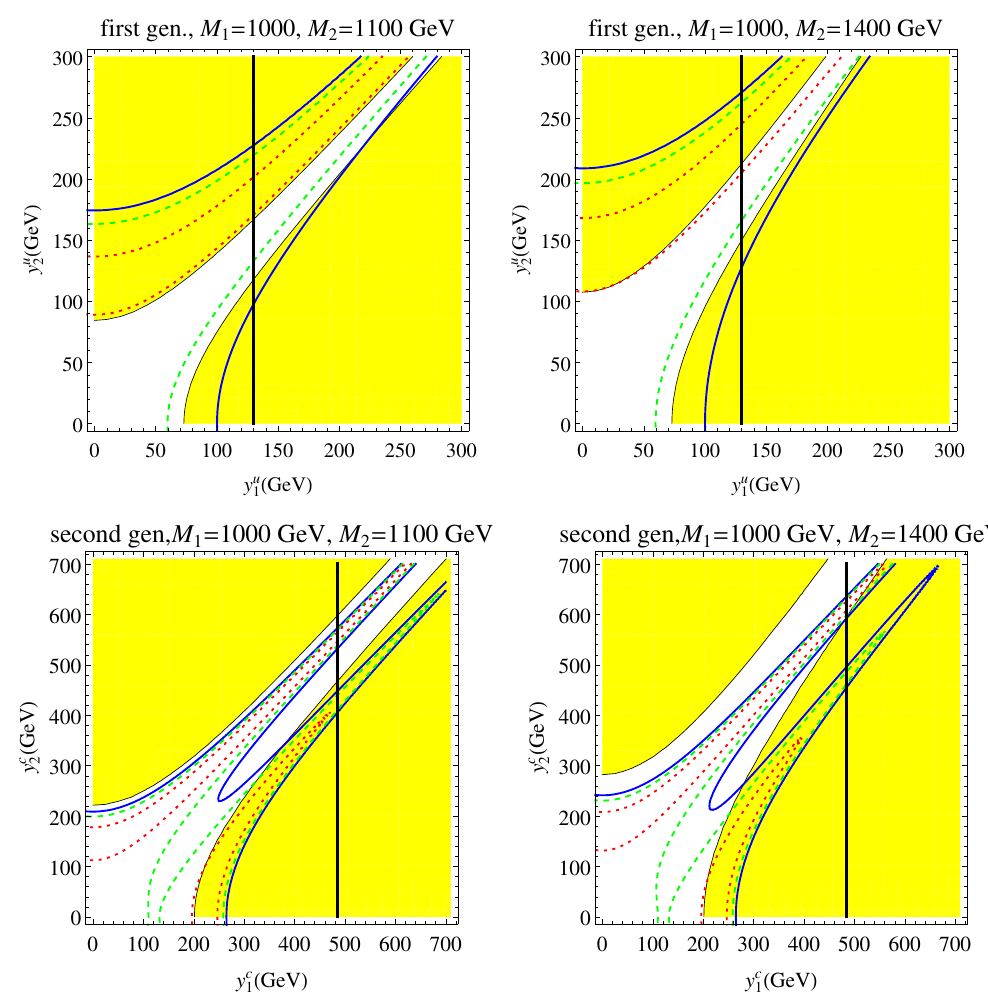
Figure 1 . Tree level (yellow area is excluded at 3 (cid:27) ), EWPT (blue continuous line corresponds to the 3 (cid:27) bound, green dashed to 2 (cid:27) , red dotted to 1 (cid:27) , the strip between the lines is allowed) and LHC single VLQ production bounds (vertical black line, excluded region on the right) in the case of mixing of two VLQ multiplets with the (cid:12)rst (top panels) or second (bottom panels) SM quark generation. Plots on the left column correspond to benchmark masses M 1 = 1000 GeV and M 2 = 1100 GeV, while on the right to M 1 = 1000 GeV and M 2 = 1400